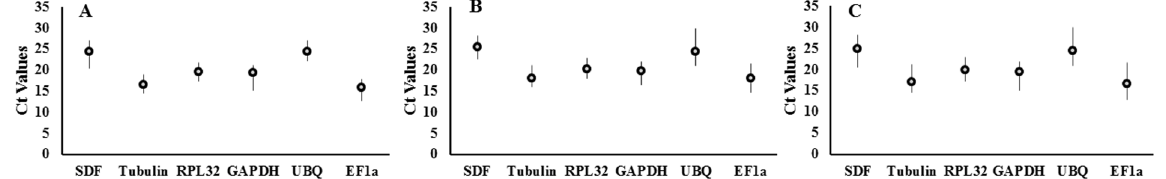
Figure 2. Identification of stable reference genes. Ct values of the five candidate reference genes in three independent experiments. Data obtained using RNA isolated from larval tissues ( A ) adult tissues ( B ) and pooled RNA from both larvae and adults ( C ) are shown. Black bars show the maximum (Max) and the minimum (Min) Ct values.